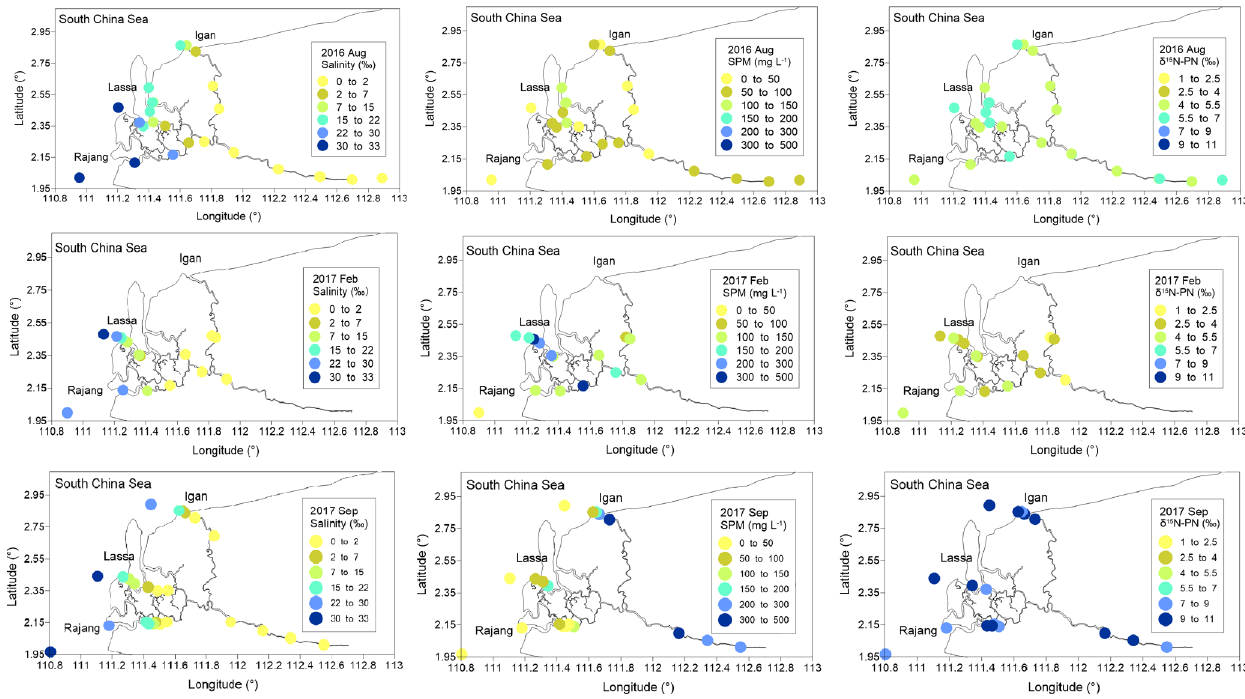
Figure 2. Distribution of salinity, suspended particle matter (SPM) and δ 15 N–PN in the Rajang estuary and the adjacent coastal